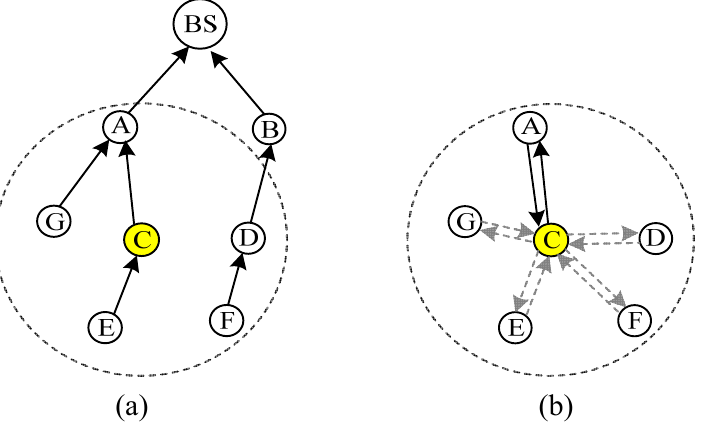
Figure 4. (a) A routing topology. (b) Focus on the nodes in the circle of (a). For node C, only the bidirectional link between C and A effects the reliability of packet